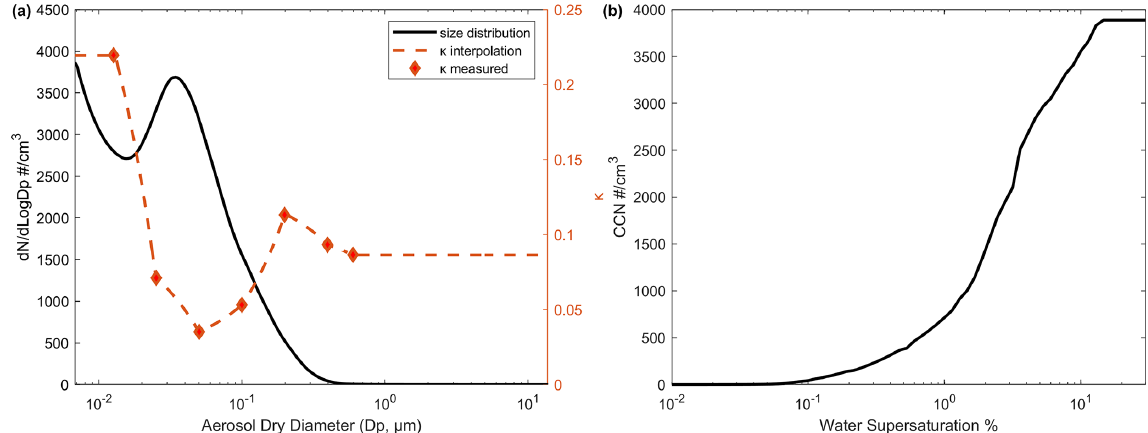
Figure 1. Example data products from 30 January 2012 at 5:20UTC, with the size (left; black solid line), κ (left; orange dashed line), and CCN (right) distributions shown. Measured κ points are shown with markers, with linearly interpolated values as dashed